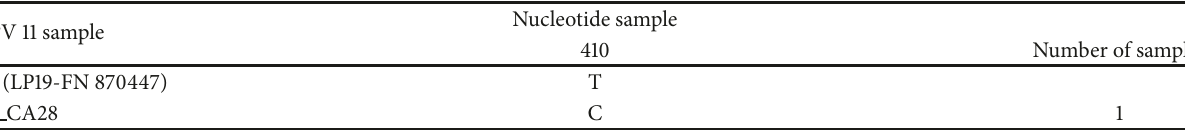
Table 3: Nucleotide alterations in the E6 genes of HPV11 isolates. Genomic positions are indicated in the upper part of the table, and the mutation is horizontally indicated. The column “Number of samples” indicates the number of patients in which the isolates are identical to the specified